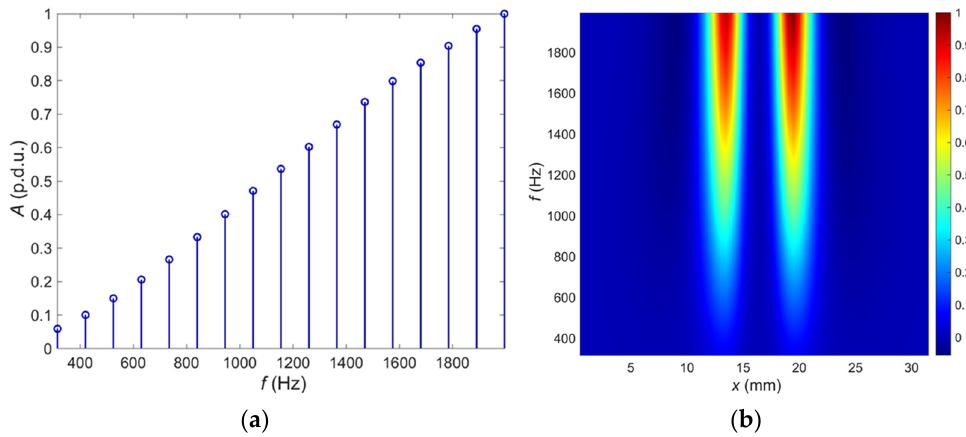
Figure 6. An example of: ( a ) the A-scan–frequency characteristics, position of the sensor x = 19.5 mm, y = 15.5 mm; ( b ) B-scan–spectrogram, position of the sensor y = 15.5 mm. Finally, the signal value three-dimensional plot against frequency f and the transducer position coordinates ( x , y ) corresponds to a D-scan. The C-scans taken for the selected frequencies will be the input images to the automatic defect recognition system using image quality assessment based on